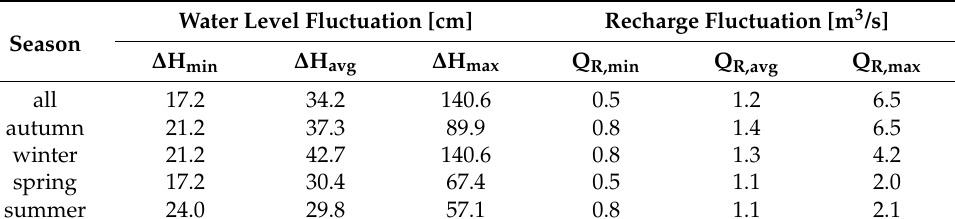
Table 2. Summary of the calculated daily water level fluctuation and corresponding recharge data.